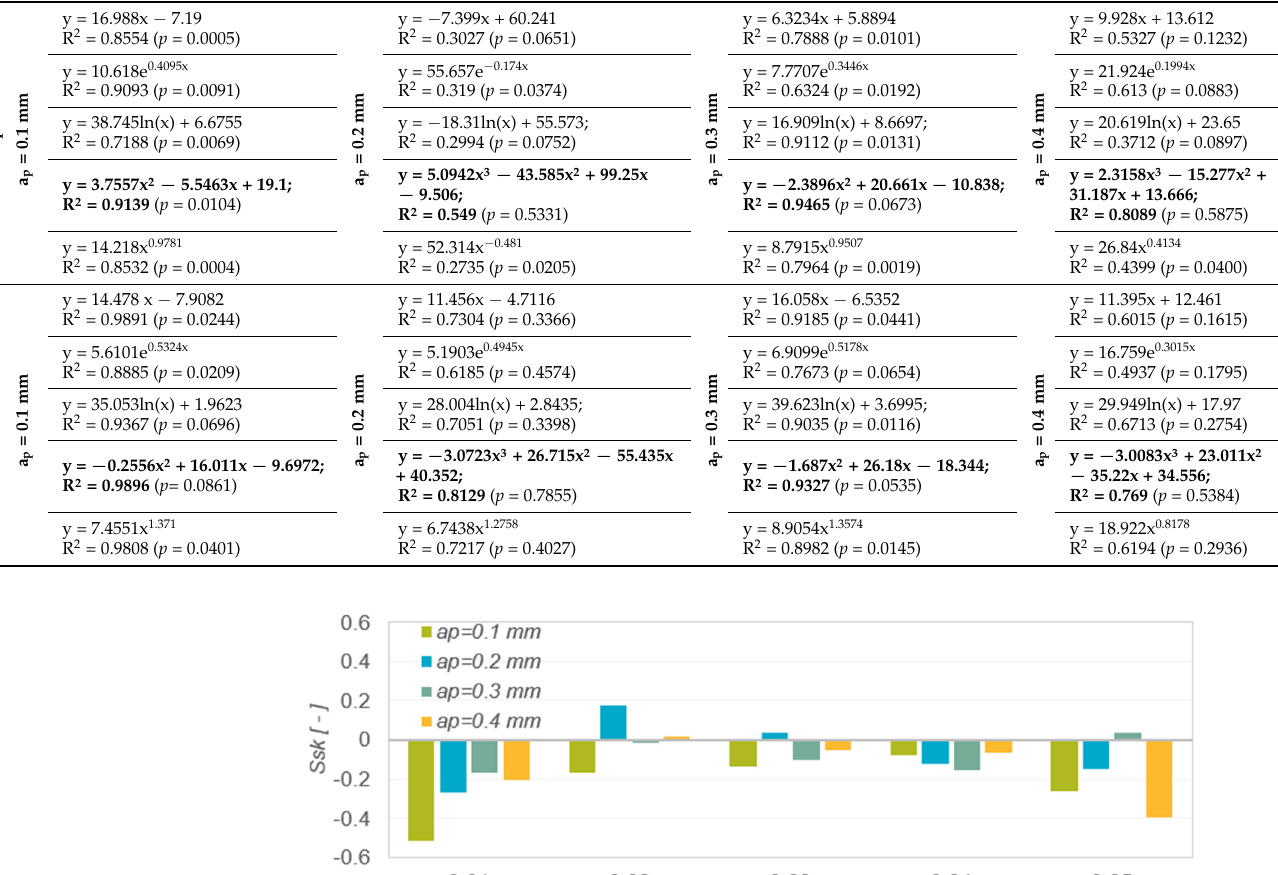
Table 5. Results of mathematical modelling of the Sv and Sp parameters as a function of the feed rate for various values of the depth of cut (regression functions y = Sv(f z ), y = Sp(f z ); f z = x with the coefficient of determination R 2 ).